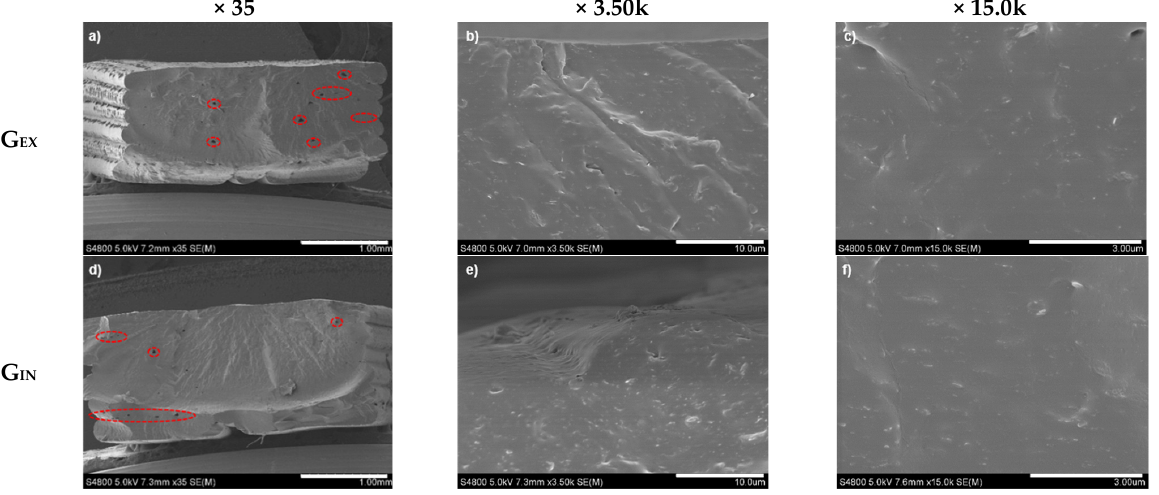
Figure 10. SEM images for 3D3G EX with a magnification of ( a ) 35, ( b ) 3.5k and ( c ) 15.0k; and for 3D3G IN with a magnification of ( d ) 35, ( e ) 3.5k and ( f ) 15.0k.